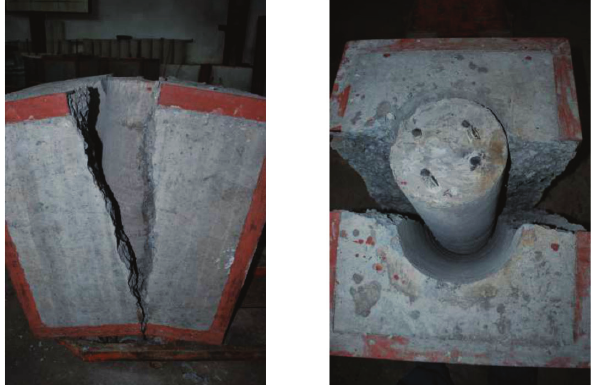
Photo 2. Form of specimens failure